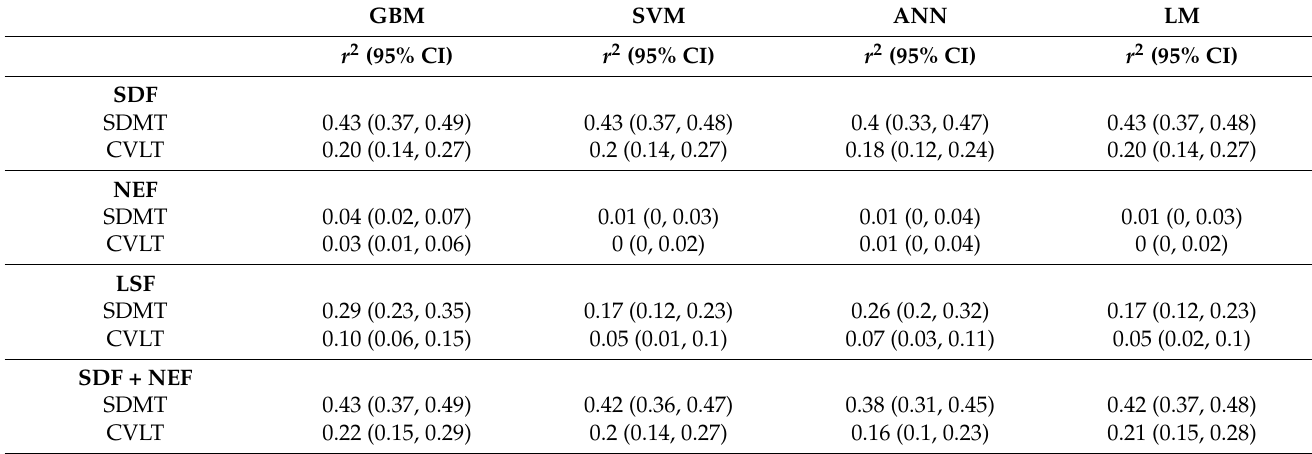
Table 2. Coefficient of determination [ r 2 and 95% CI] values of association between predicted and measured processing speed (SDMT) and memory scores (CVLT). Performance of regression-based linear model (LM), support vector machine (SVM), neural network (ANN), and gradient boosting machines (GBM) are compared. Different combinations of sociodemographic (SDF), neighbourhood environment (NEF), and lifestyle (LSF) factors were used in the